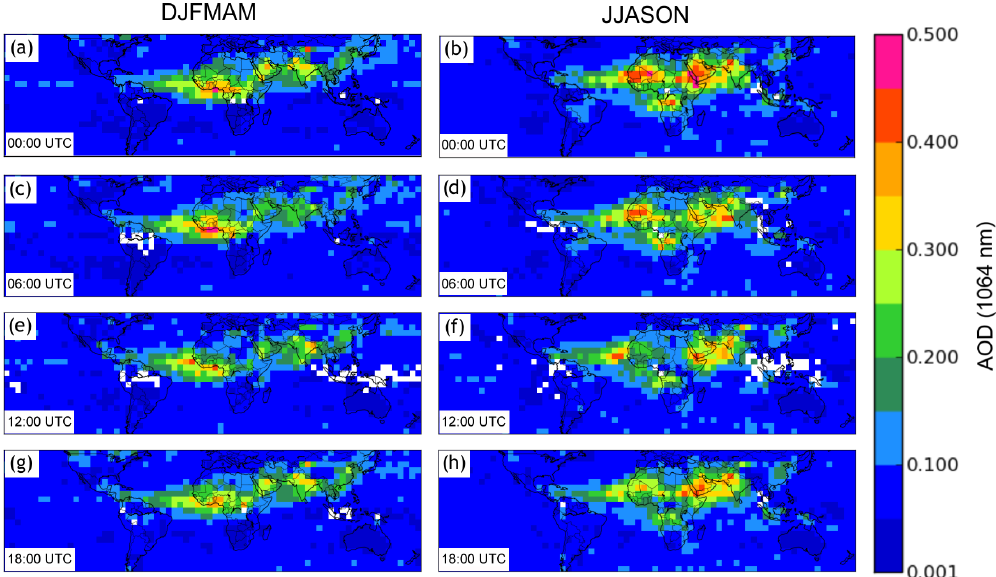
Figure 8. Seasonal mean AOD (1064nm) binned by every 6h for (a) DJFMAM 00:00UTC, (b) JJASON 00:00UTC, (c) DJFMAM 06:00UTC, (d) JJASON 06:00UTC, (e) DJFMAM 12:00UTC, (f) JJASON 12:00UTC, (g) DJFMAM 18:00UTC and (h) JJASON 18:00UTC. Table 3. CALIOP and CATS mean AODs/AOD standard deviations for regions as highlighted in Fig. 6 and globally within ± 52 ◦ latitude. Region Latitude Longitude Mean CATS AOD Mean CALIOP AOD Mean CATS Mean CALIOP (DJFMAM/JJASON) (DJFMAM/JJASON) SD SD (DJFMAM/JJASON) (DJFMAM/JJASON) Global 52 ◦ S–52 ◦ N 180 ◦ W–180 ◦ E 0.09/0.10 0.09/0.09